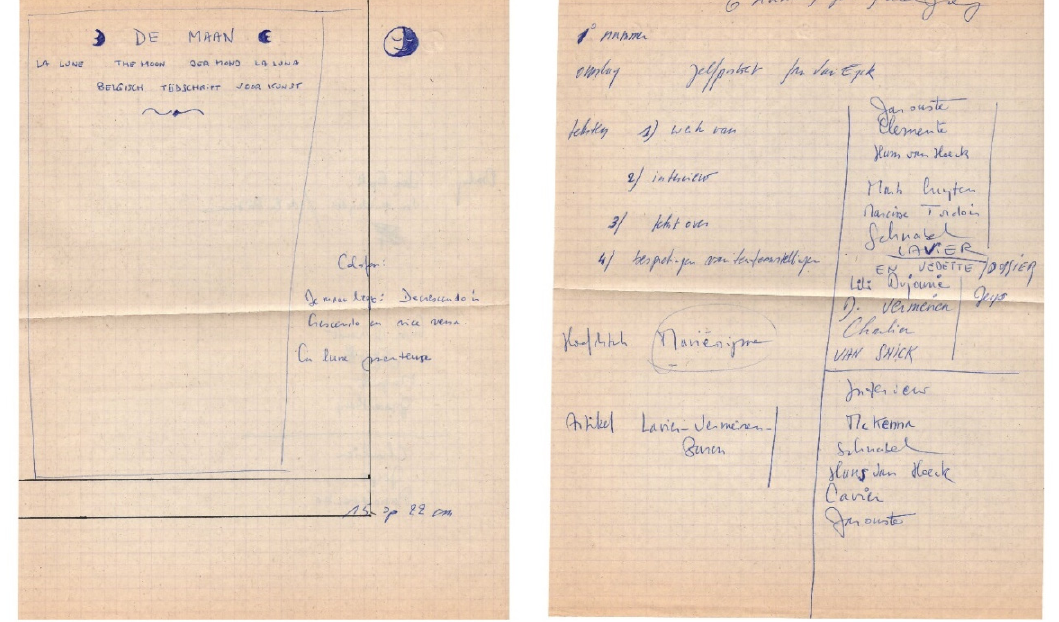
Figure 9. Sketch for “De Maan (La lune, the moon, der Mond, la luna). Belgisch Tijdschrift voor Kunst.” (1982). The sketch contains an outline of the content for the first issue, whose cover would reproduce the self-portrait by Jan van Eyck. (Brussels: Jan Vercruysse Foundation). (Reprinted with permission from Jan Vercruysse